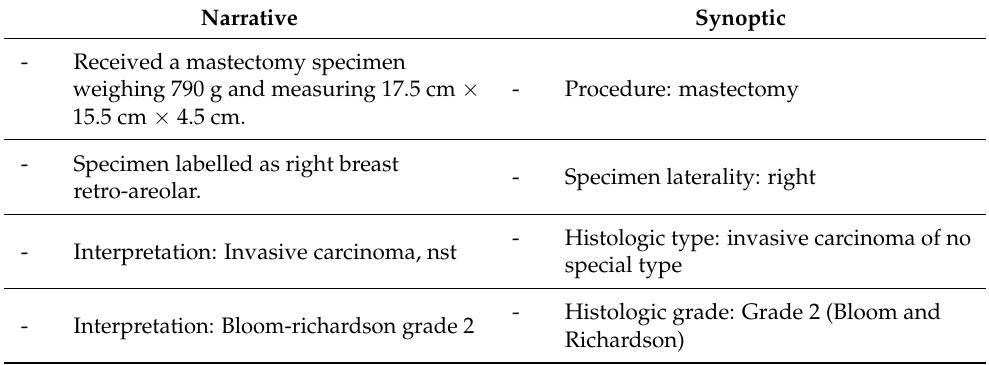
Table 4. Examples of pathology report information in narrative and synoptic format,